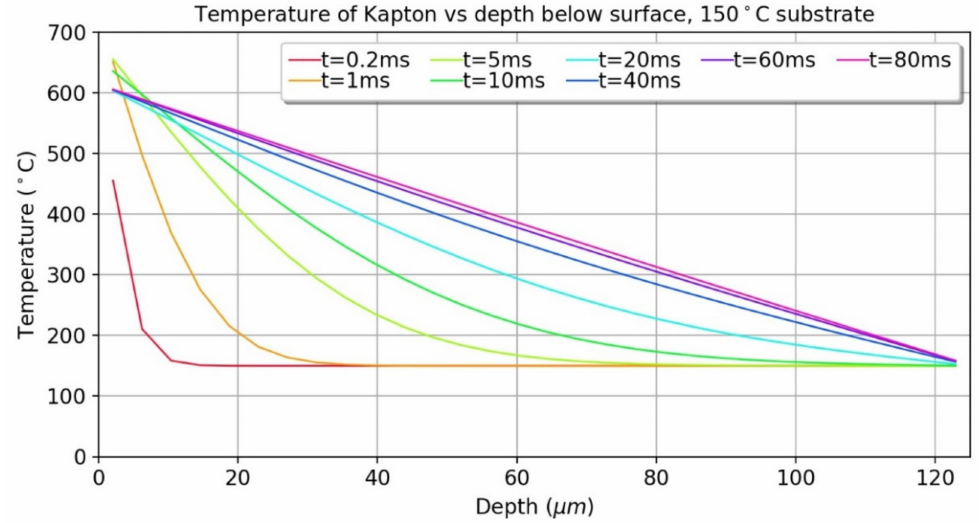
Figure 7. Substrate temperature versus depth beneath the substrate’s top surface when the substrate is heated to 150 ◦ C.